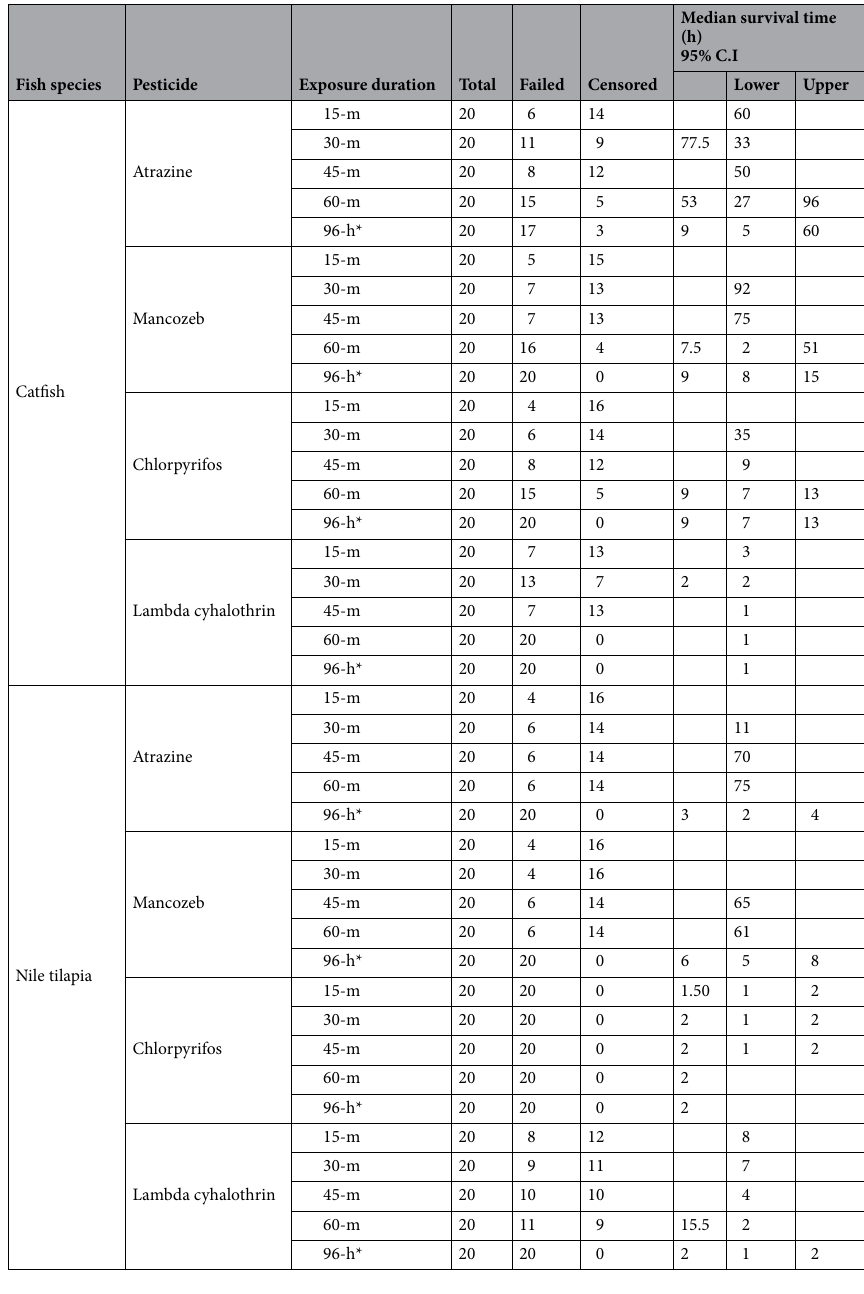
Table 5. Mortality count and median survival time of fingerings pulse exposed to pesticides. C.I, Confidence interval. Median survival time and confidence interval was only estimated when 50% mortality occur; m-minutes, h-hours *- continuous